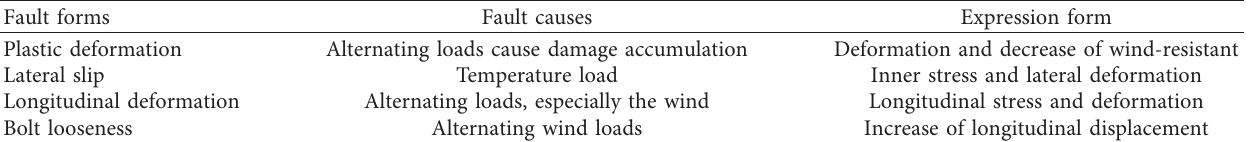
Table 1: Main fault and causes of metal